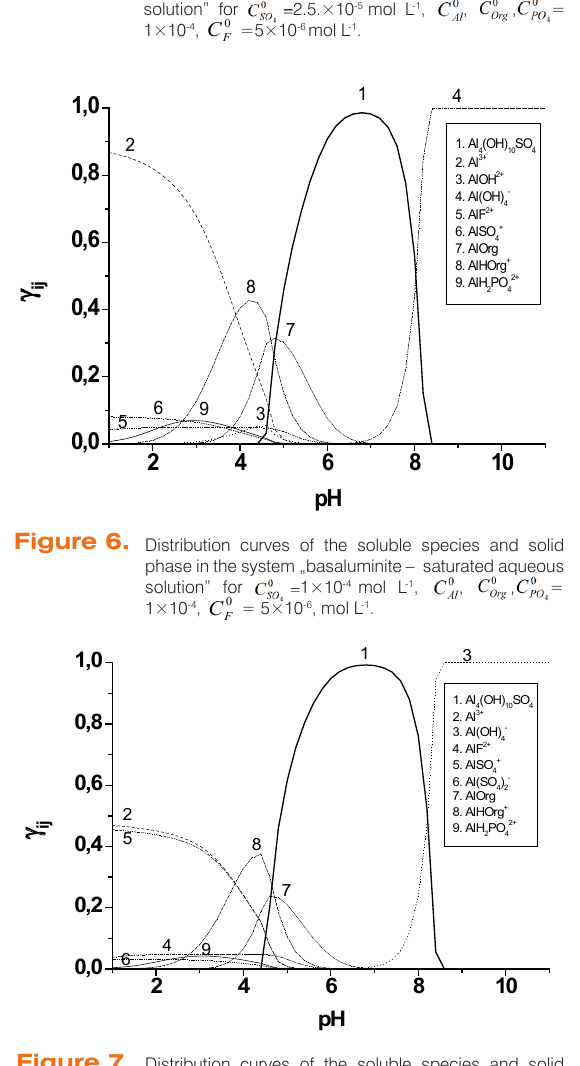
Distribution curves of the soluble species and solid phase in the system „basaluminite – saturated aqueous solution” for